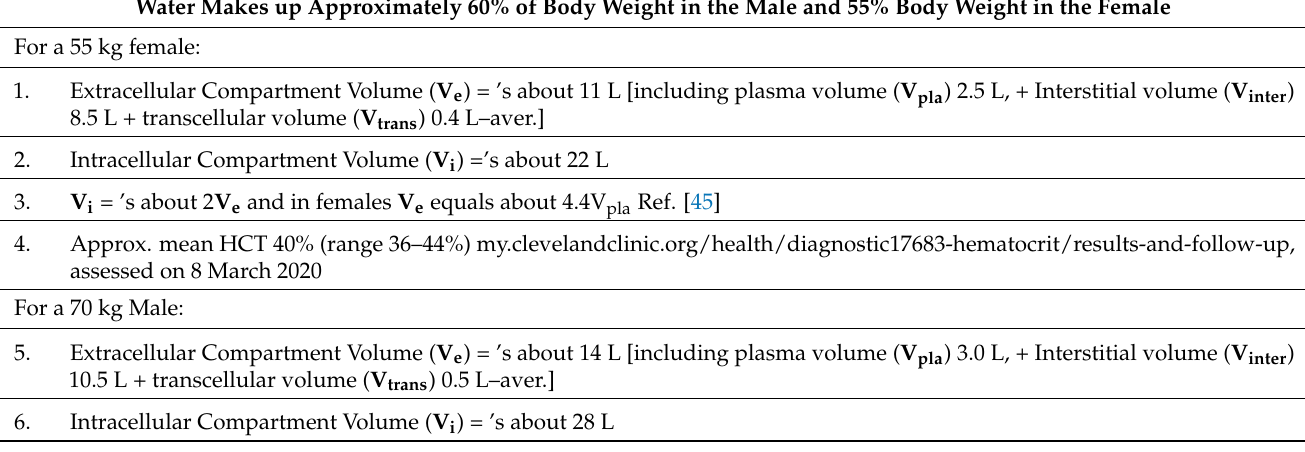
Table 1. Intracellular and Extracellular Compartment Volume